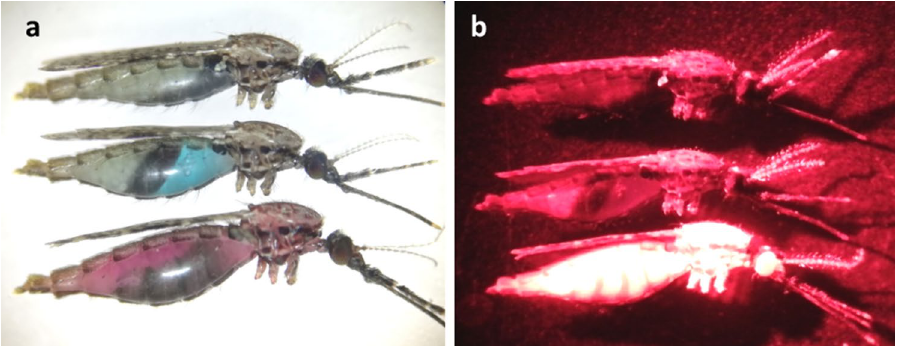
Figure 1. The image of An. cracens observed under the stereomicroscope ( a ) and fluorescent microscope ( b ). The mosquito on the top did not take any second meal; middle had taken sucrose solution infused with Brilliant blue dye while the bottom had taken second blood meal infused with rhodamine B fluorescent